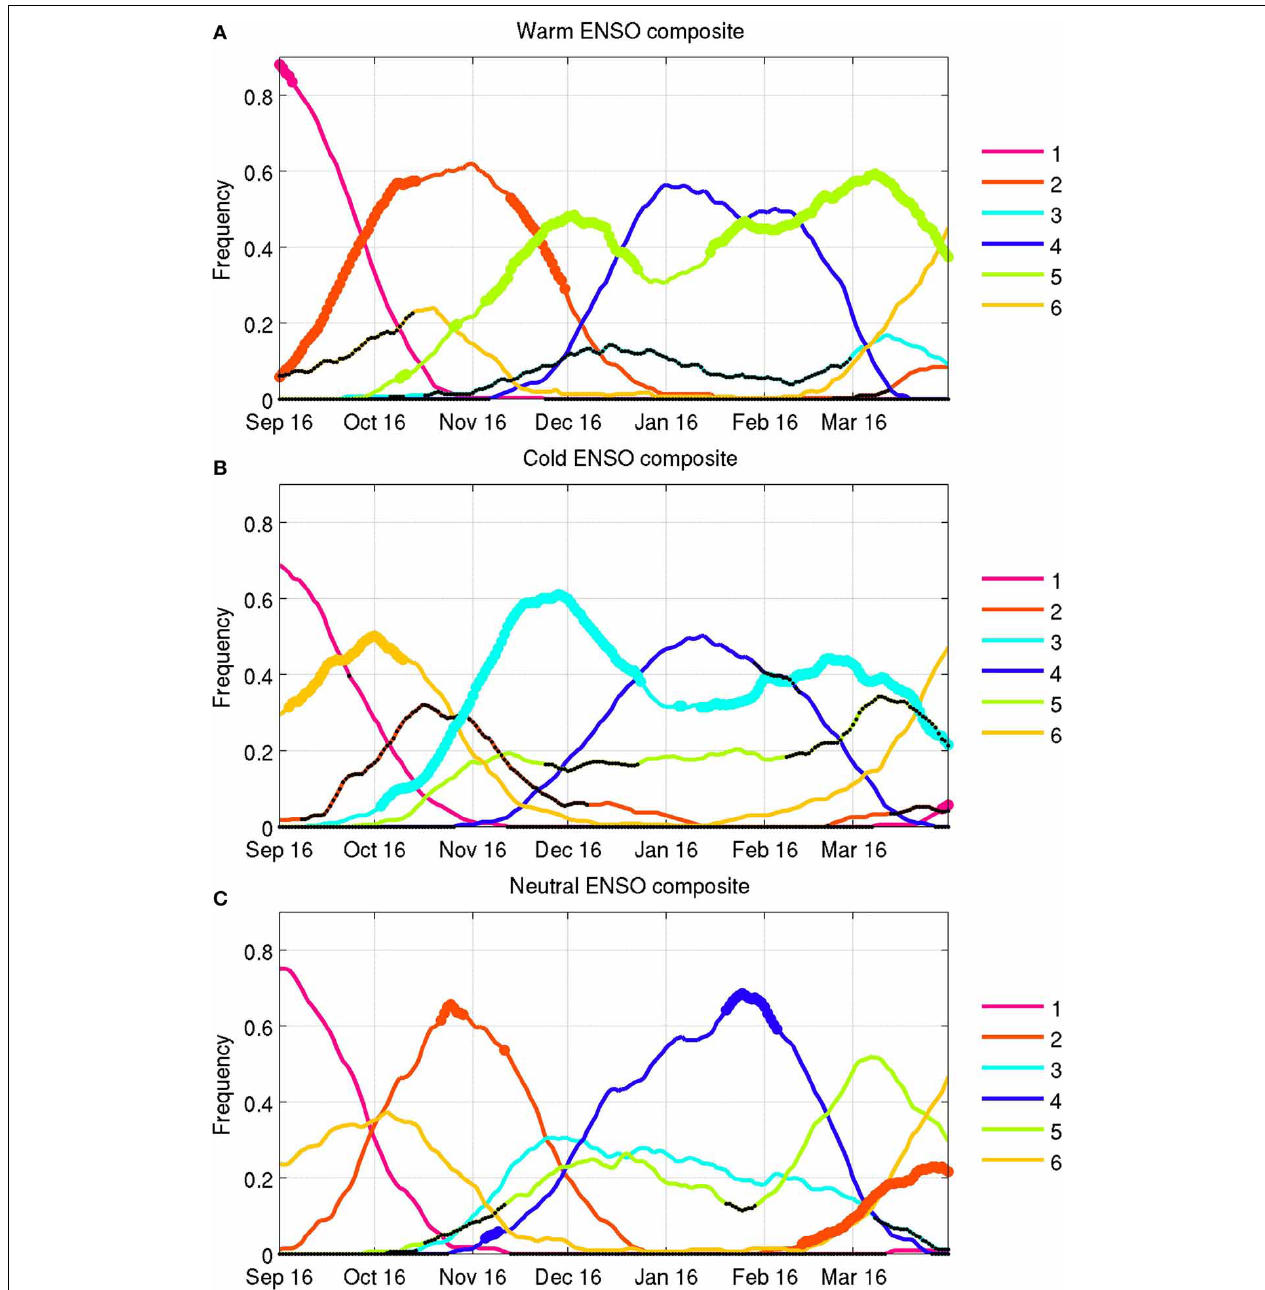
FIGURE 5 | WT composites in running 31-day windows, classified by (A) warm, (B) cold and (C) neutral ENSO events. These are defined as the mean December–February SST anomalies in the Niño 3.4 box lying above + 0 . 5 ◦ C (warm), below − 0 . 5 ◦ C (cold), and between − 0 . 5 ◦ C and + 0 . 5 ◦ C